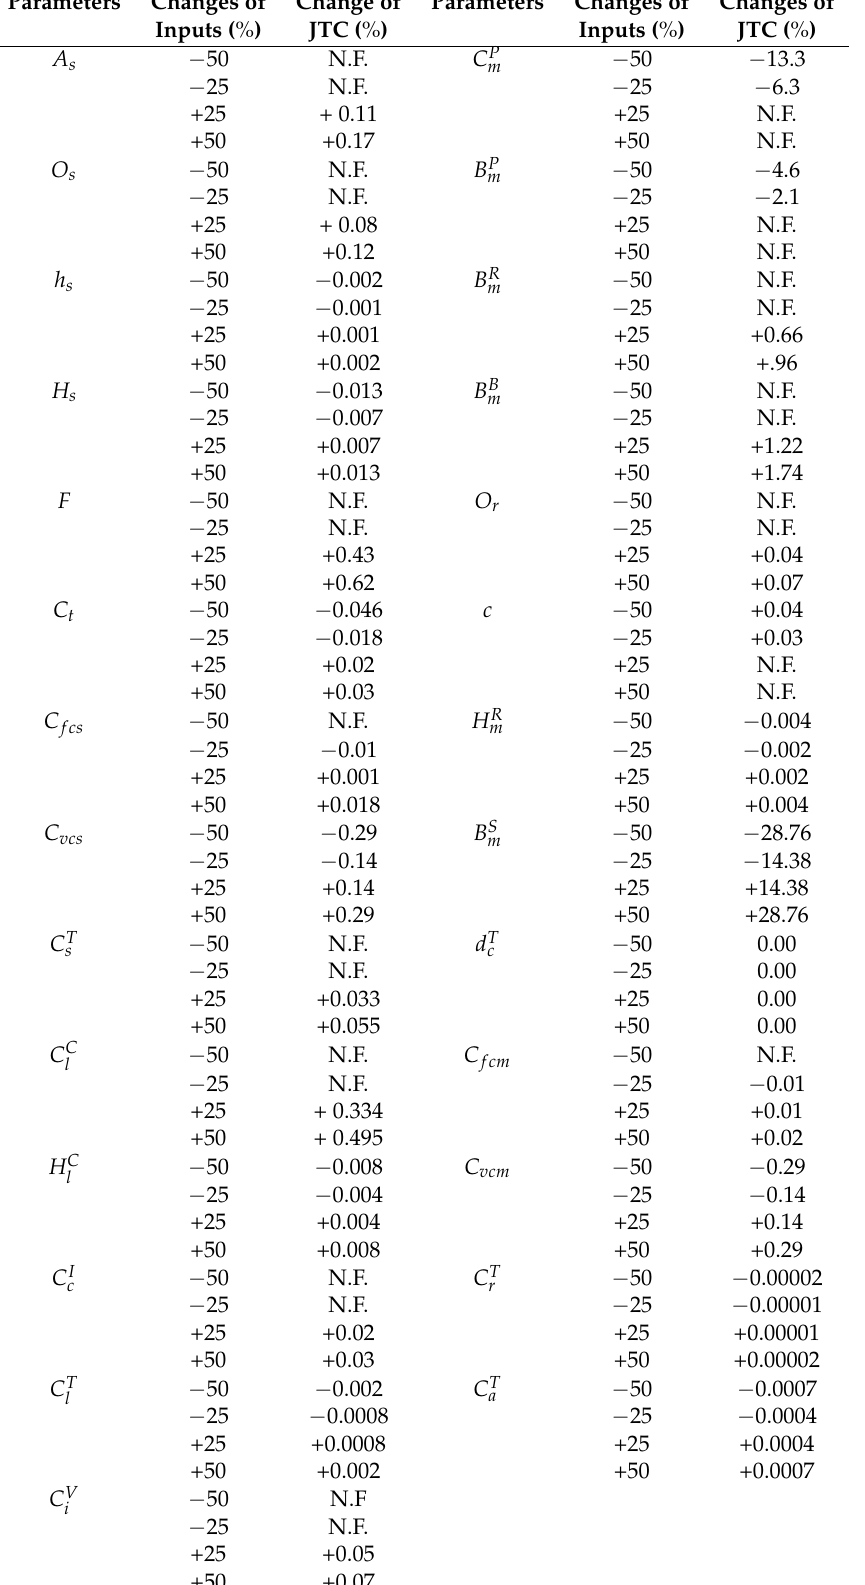
Table 6. Sensitivity analysis of known